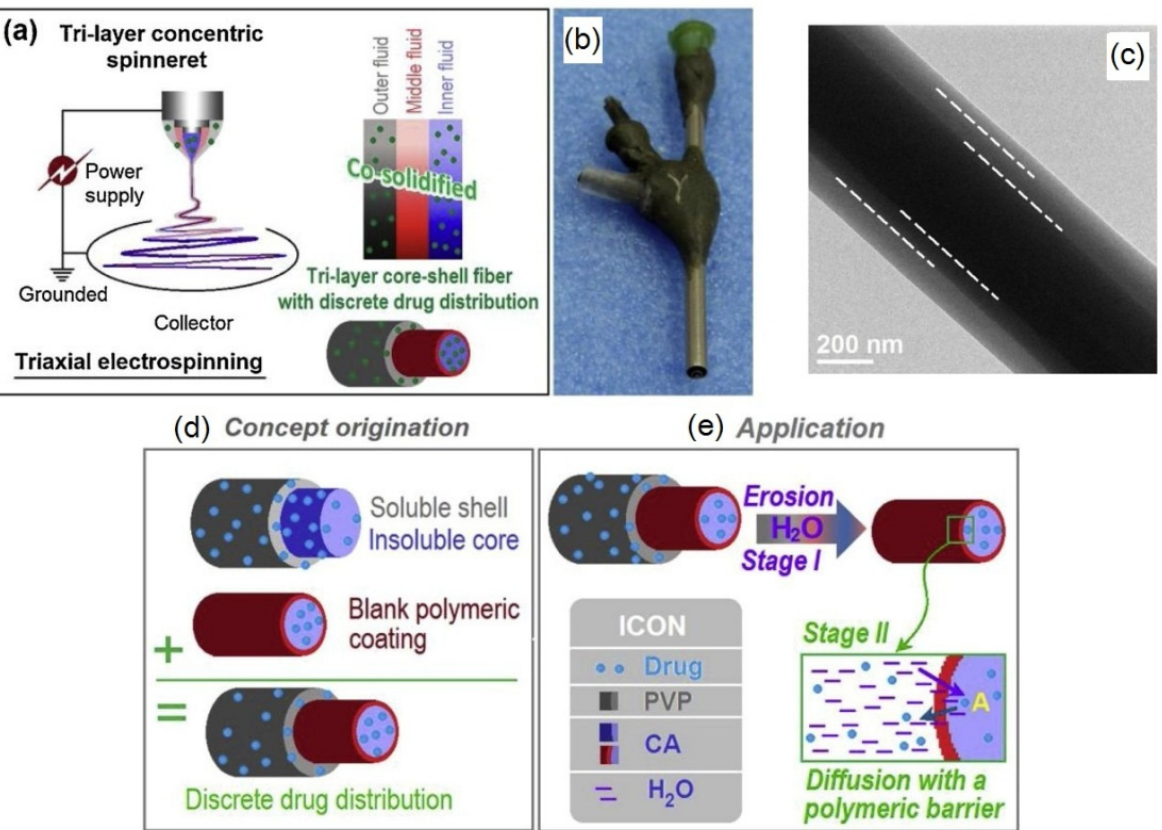
Figure 13. A scheme of triaxial electrospinning ( a ); triaxial spinneret ( b ); tricomponent fiber ( c ); scheme of the concept for triaxial spinning ( d ); application of tricomponent fiber for sustainable drug release ( e ) (reprinted and adapted from Carbohydrate Polymers , 2020 , 243 , 116477, Yang, Y.; Chang, S.; Bai, Y.; Du, Y.; Yu, D.G. Electrospun triaxial nanofibers with middle blank cellulose acetate layers for accurate dual-stage drug release, with permission from Elsevier).